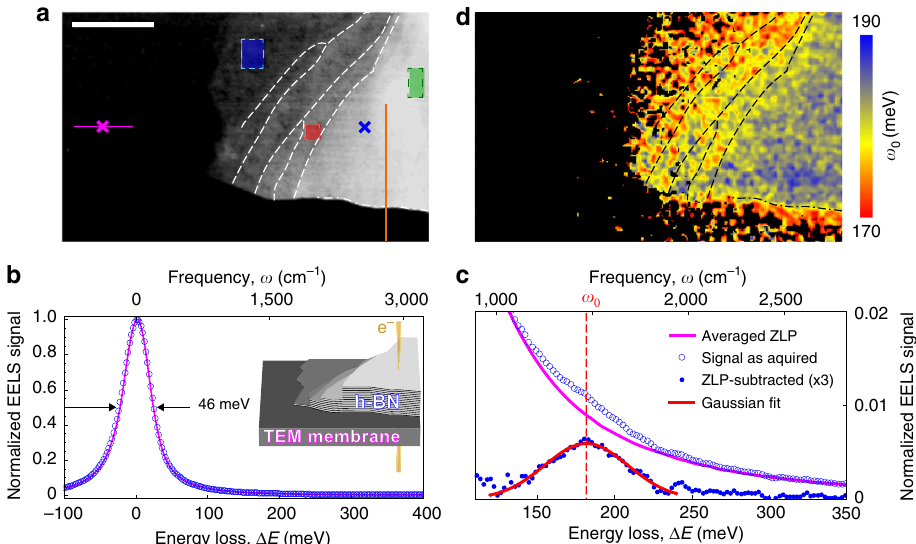
Fig. 1 STEM-EELS map of a hexagonal boron nitride fl ake. a STEM HAADF image of the h-BN fl ake on a TEM membrane. Brighter areas correspond to a larger h-BN thickness, black is the supporting TEM membrane. Scale bar, 500 nm. White dashed lines are guides marking steps on the fl ake surface, dash- dotted line marks the fl ake edge. Blue , red , and green rectangles mark the area from which the spectra in Fig. 4d were collected. Orange line shows where the data for Fig. 6c were taken from. b Typical spectra acquired on h-BN ( open circles ) and on an empty TEM membrane ( magenta ); the corresponding locations are marked, respectively, by magenta and blue crosses in a . Each spectrum is normalized to its ZLP maximum. Inset shows the 3D sketch of the sample topography from a . c Close-up view of the same spectrum as in b ( open circles ); the thick magenta curve shows the ZLP averaged along the horizontal magenta line in a . Closed circles show the spectrum after ZLP subtraction and the red curve shows a Gaussian fi t. d Map of the peak position ω 0 . Black color marks regions of insuf fi cient signal level (below 2.5x10 − 4 threshold) and of otherwise irregular fi ts (see Methods for details). Black dashed and dash-dotted lines are the same eye guides as marked in